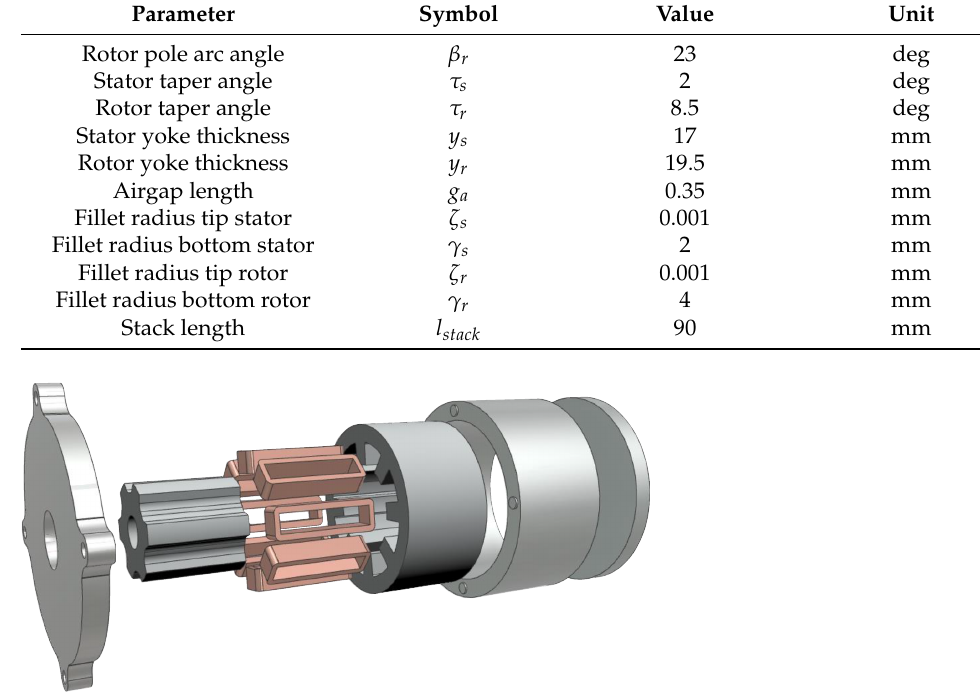
Figure 9. Exploded view of the baseline 8/6 motor assembly. Table 3. Material properties for the baseline 8/6 SRM.